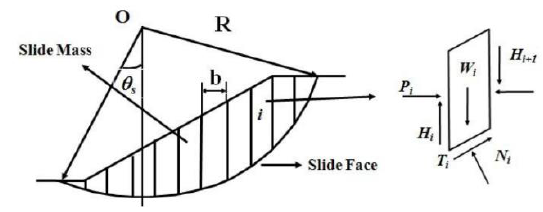
Figure 1: Slope slices and forces are acting on